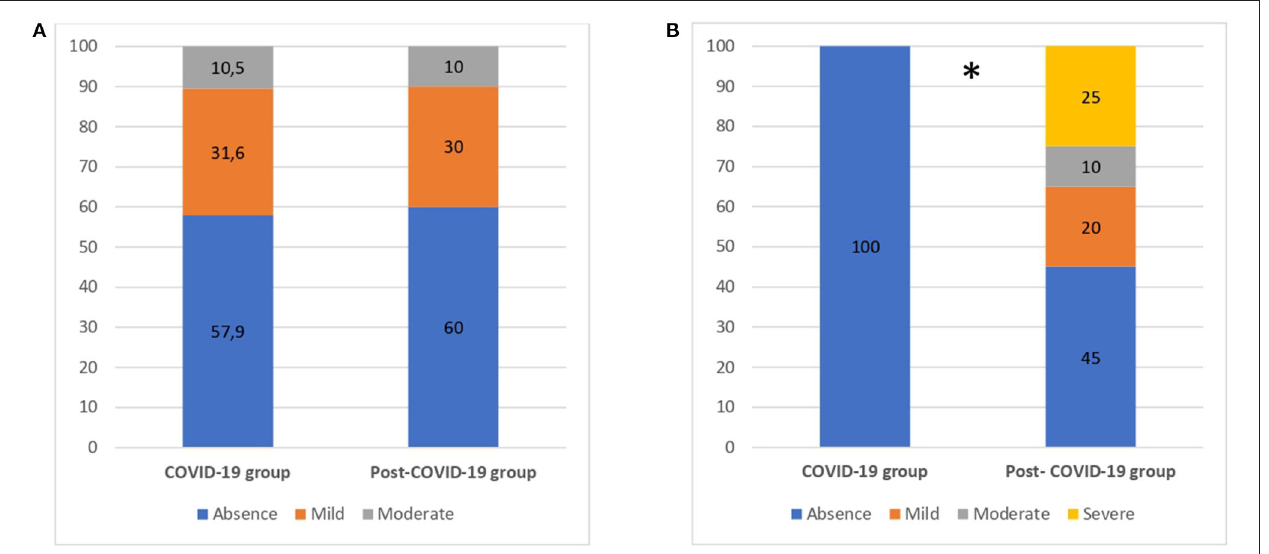
FIGURE 2 | Emotional disturbances for COVID-19 and post-COVID-19 patients. (A) Depression. (B) Psychological distress. Numbers are reported as %. * p <